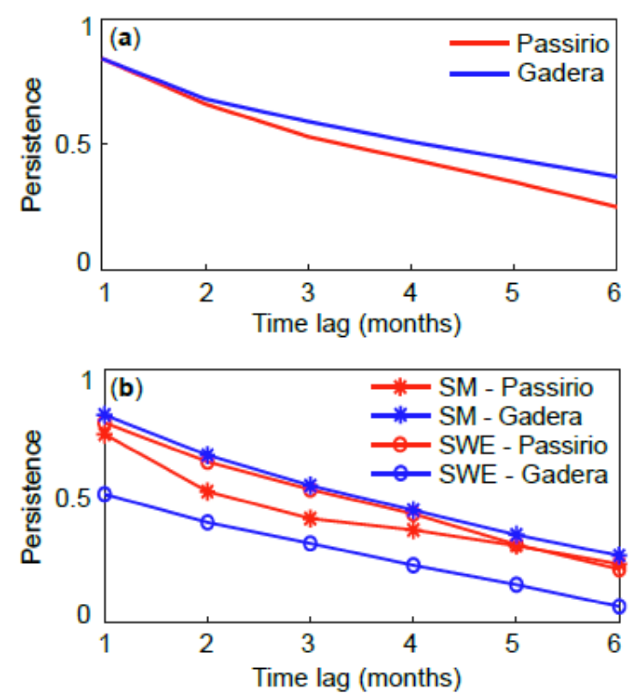
Figure 2. ( a ) Persistence of the land surface moisture states (sum of snow water equivalent (SWE) and subsurface water content (SWC)); and ( b ) persistence of the individual moisture states (SWE, SWC) in the two case studies.